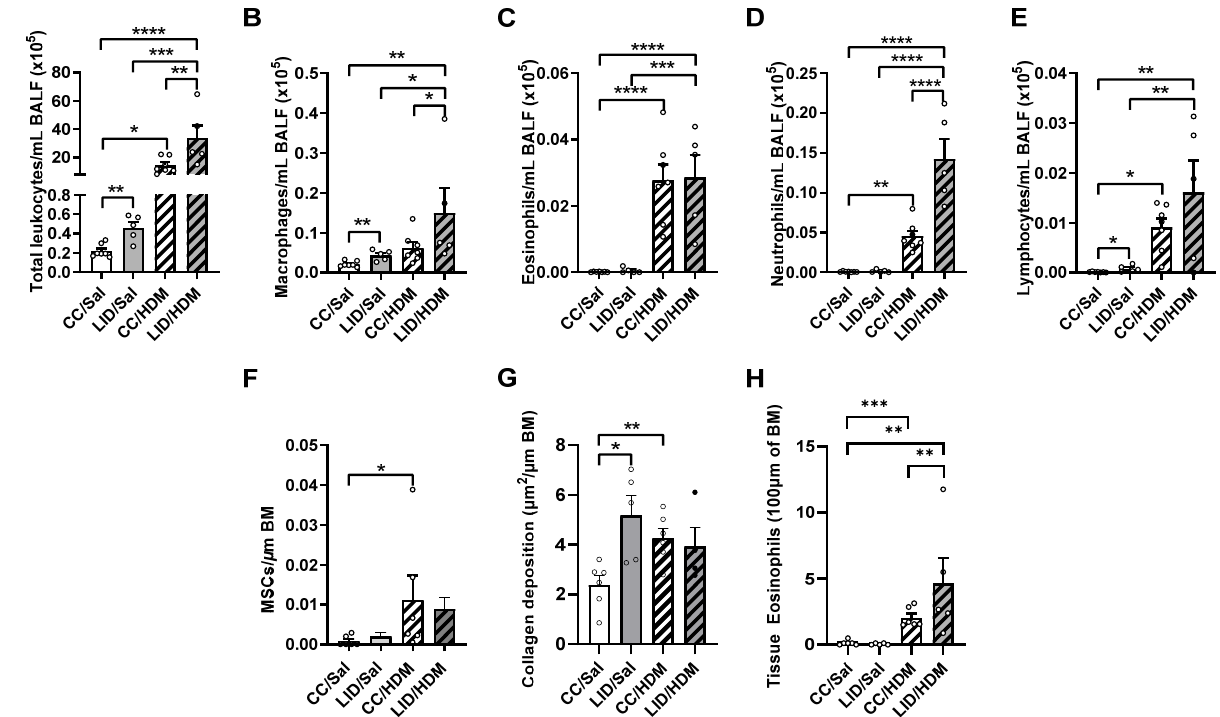
Figure 5. Low iron diet (LID) during pregnancy increases airway inflammation and collagen deposition in female offspring in the absence and presence of HDM. ( A ) Total leukocytes, ( B ) macrophages, ( C ) eosinophils ( D ) neutrophils and ( E ) lymphocytes were enumerated in bronchoalveolar lavage fluid (BALF) at five weeks. Histopathology was assessed in terms of ( F ) mucus secreting cells (MSCs) per µ m of basement membrane (BM), ( G ) small airway collagen deposition and ( H ) airway-associated eosinophils. n = 5–7 mice per group. Data analysed by one-way ANOVA with Fishers LSD and unpaired student t -test Data are presented as mean ± SEM (* p < 0.05; ** p < 0.01; *** p < 0.001; **** p < 0.0001).